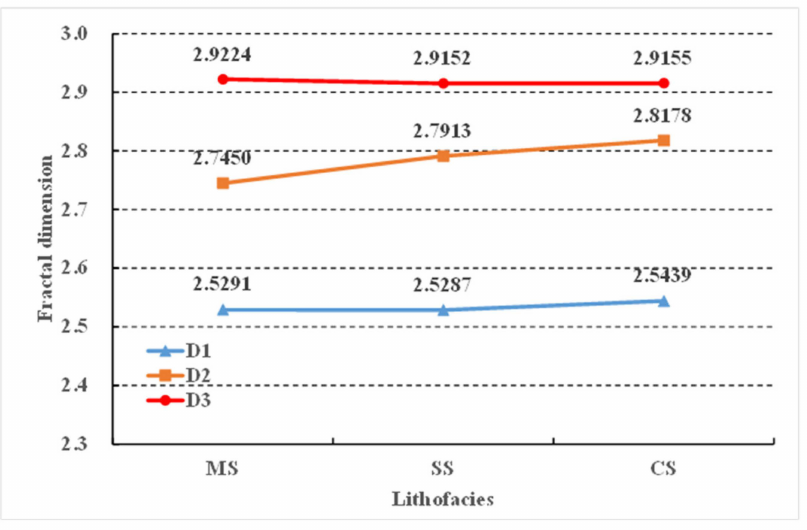
Figure 13. Fractal dimension distribution of different shale